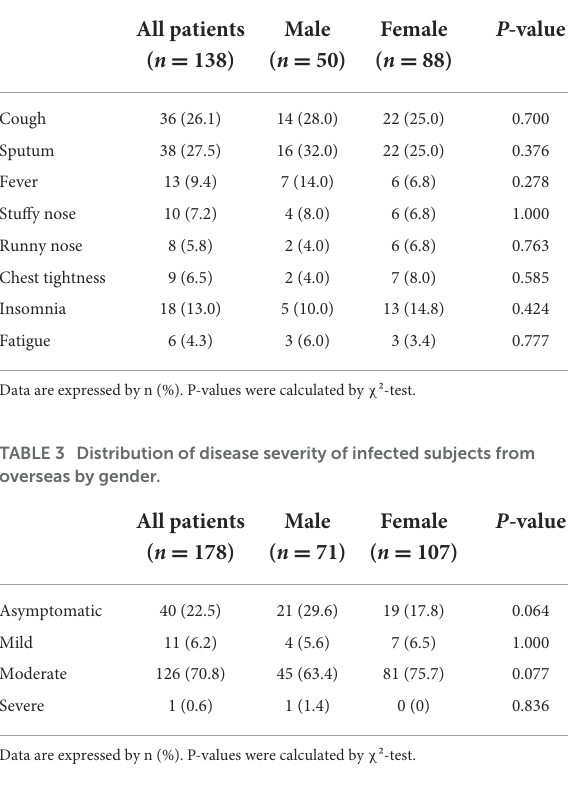
TABLE 1 Demographic results of infected subjects from overseas by gender.